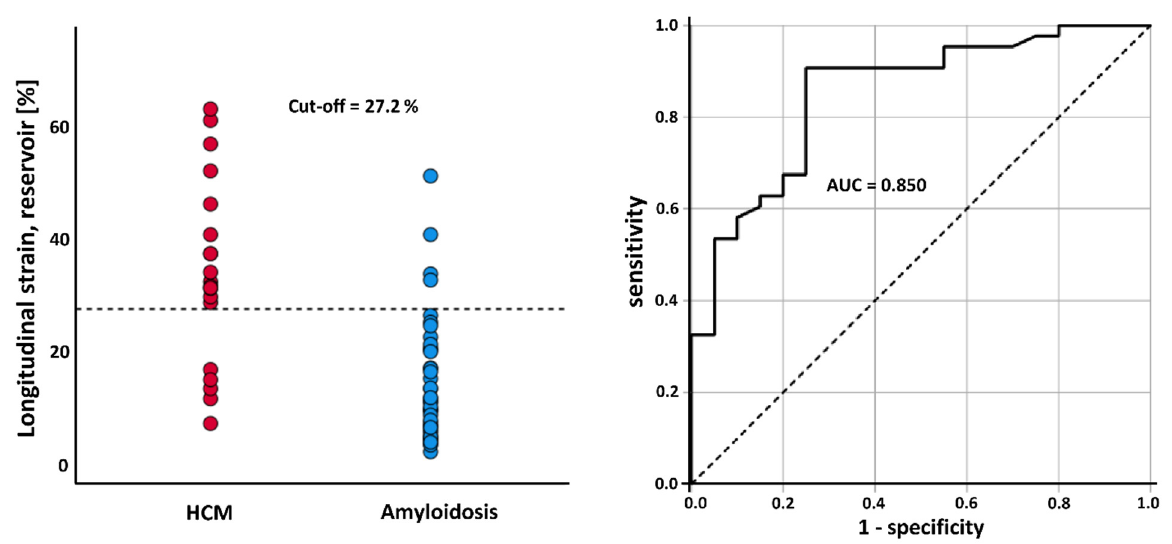
Figure 3. ROC analysis of booster longitudinal strain rate between HCM patients and CA patients. Table 2. ROC analyses of RAS and RASR for differentiation of CA and HCM patients. Cut-Off Value AUC Quality